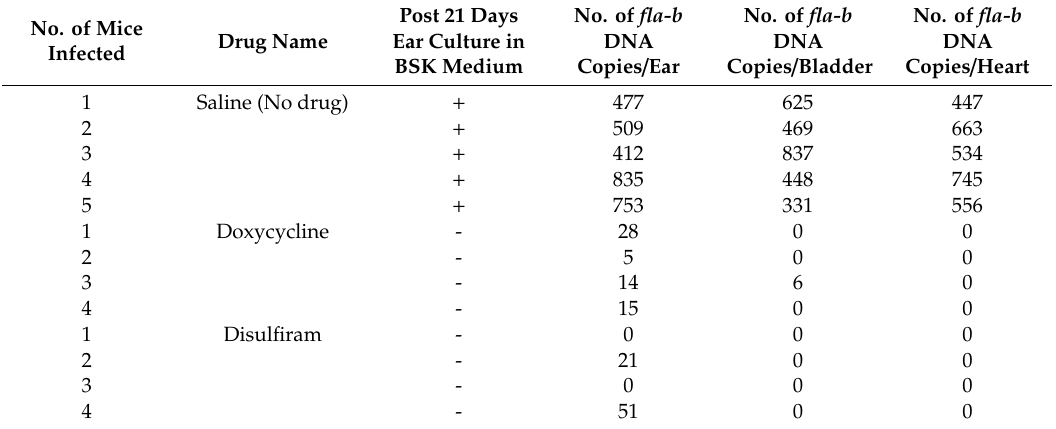
Table 2. In vivo e ffi cacy of drugs against B. burgdorferi in C3H / HeN mice (on day